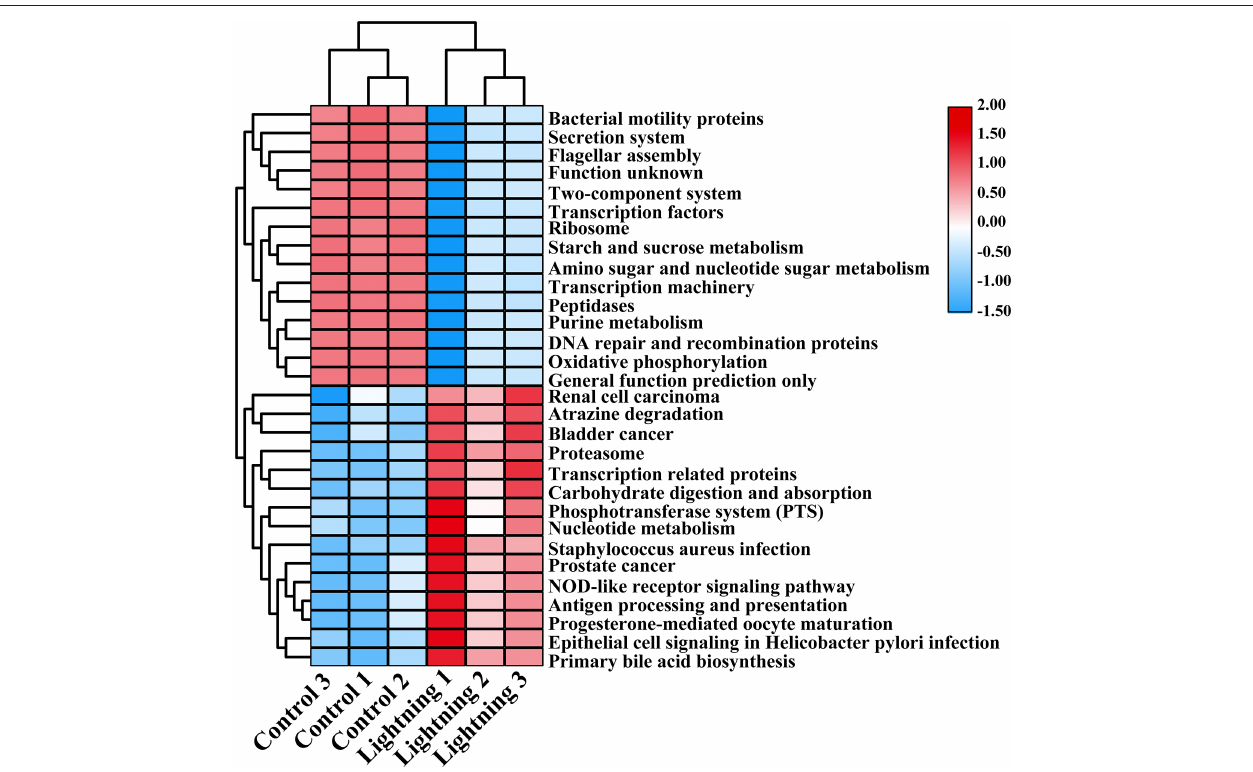
FIGURE 6 | Kyoto Encyclopedia of Genes and Genomes (KEGG) functions significantly enriched between different samples ( P < 0.05). The color block in the heat map from green to red indicates that the abundance of the sample increases gradually. Lighting represents a sample 10m from the lightning rod; Control indicates that the distance between the sample and the lightning rod is >